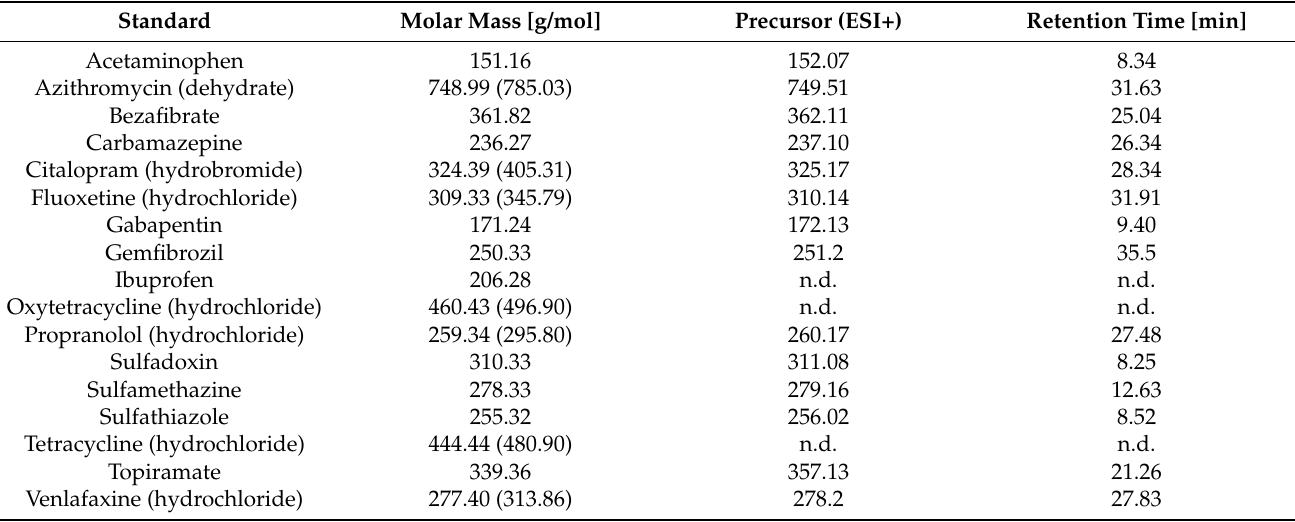
Table 1. Retention time and precursors of the xenobiotic standards analyzed by LC-MS.